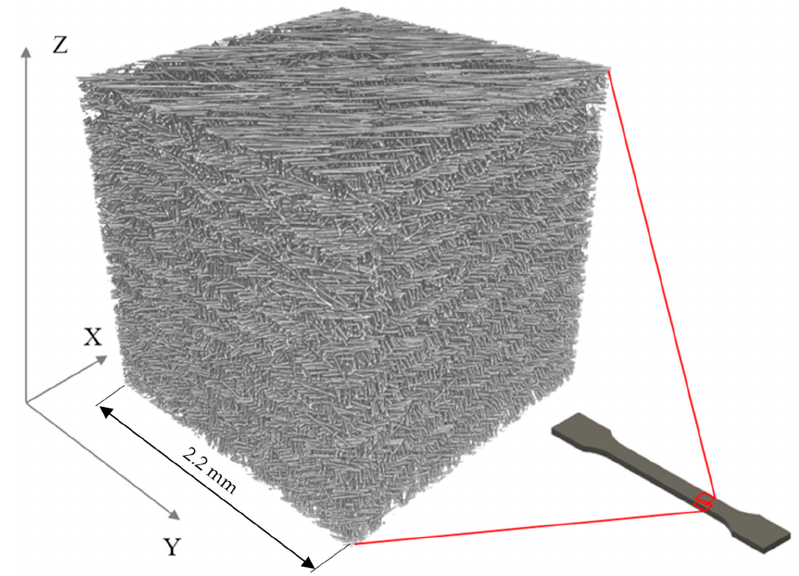
Figure 2. 3D visualization of the micro-CT image of a specimen with a raster angle of (45, 135) and a size of roughly 10 mm 3 (10,003 pixel 3 volume), printed with a 0.10 mm layer thickness. Materials 2020 , 13 , x FOR PEER REVIEW